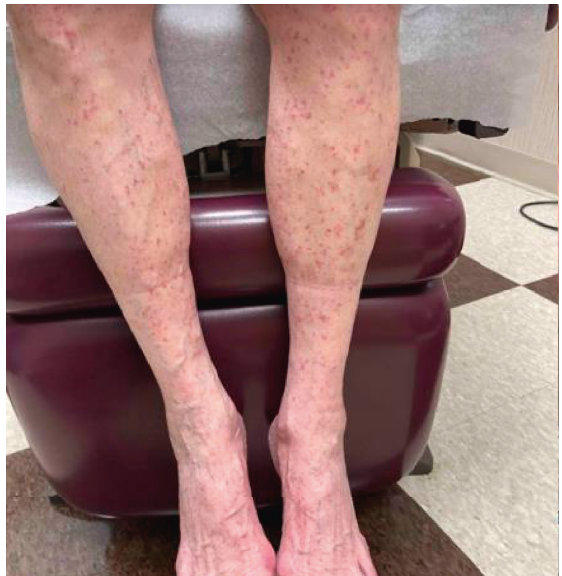
Figure 1: Image of the patient’s bilateral lower legs demonstrating symmetrically distributed small, red, violaceous petechiae.